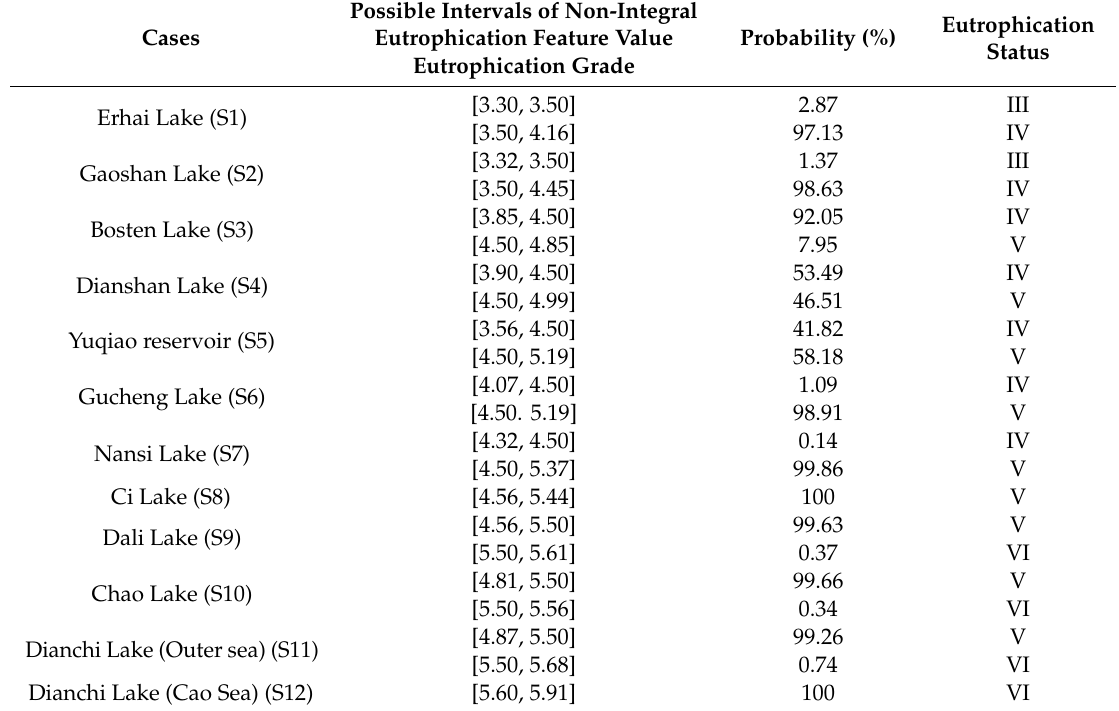
Table 7. Probable intervals of non-integral eutrophication grade, corresponding probabilities, and comprehensive eutrophication